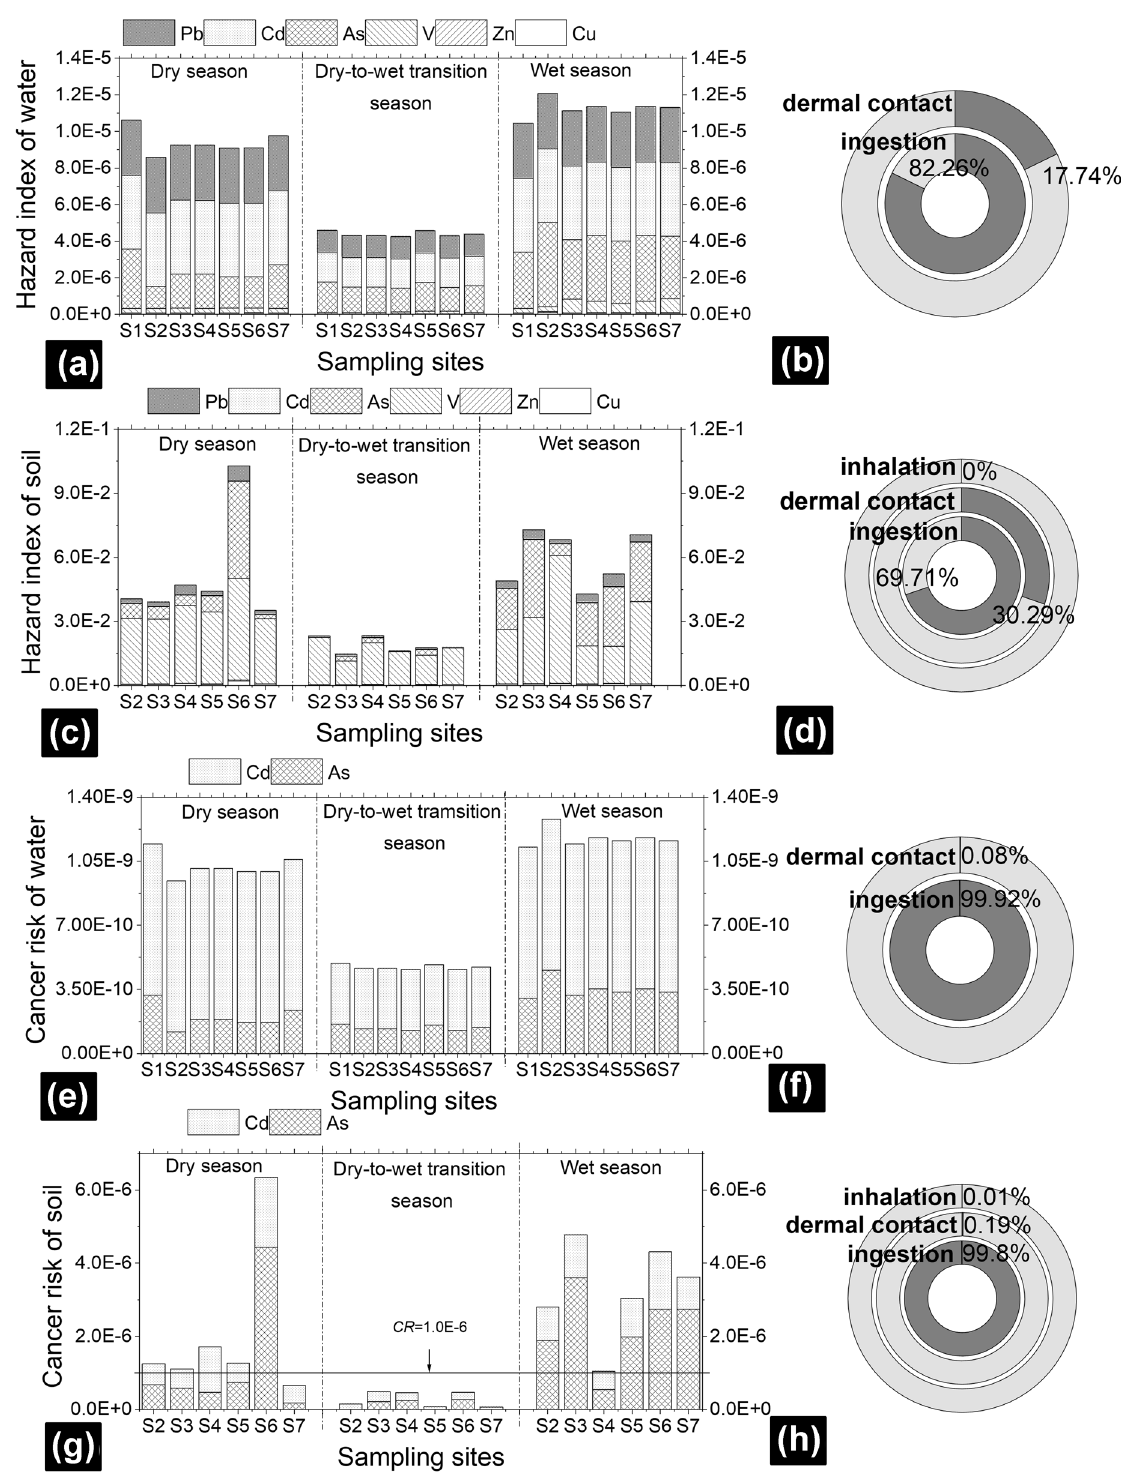
Figure 3. The hazard indices of water ( a ) and soil ( c ) and the contributions of exposure routes to the hazard index of water ( b ) and soil ( d ). The cancer risk of water ( e ) and soil ( g ), and the contributions of exposure routes to the cancer risk of water ( f ) and soil ( h